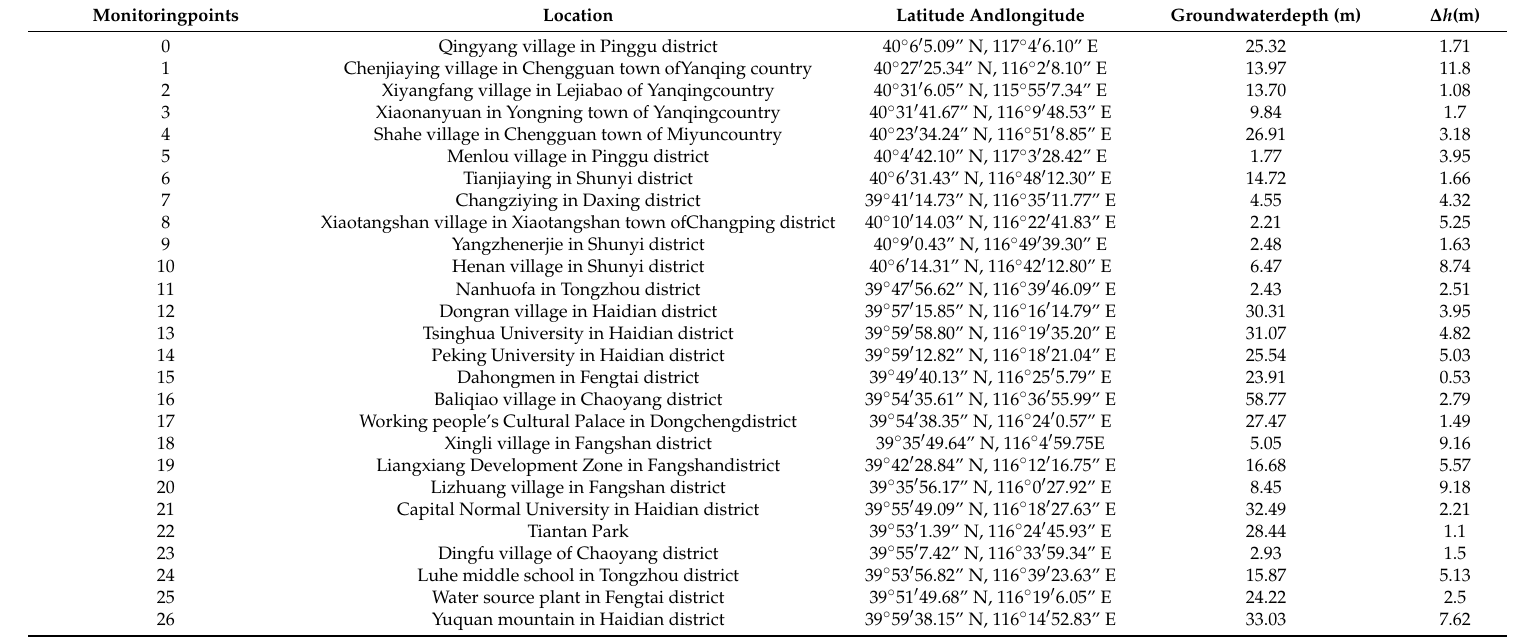
Note: Groundwater depth and water level variation ( ∆ h ) is the annual average